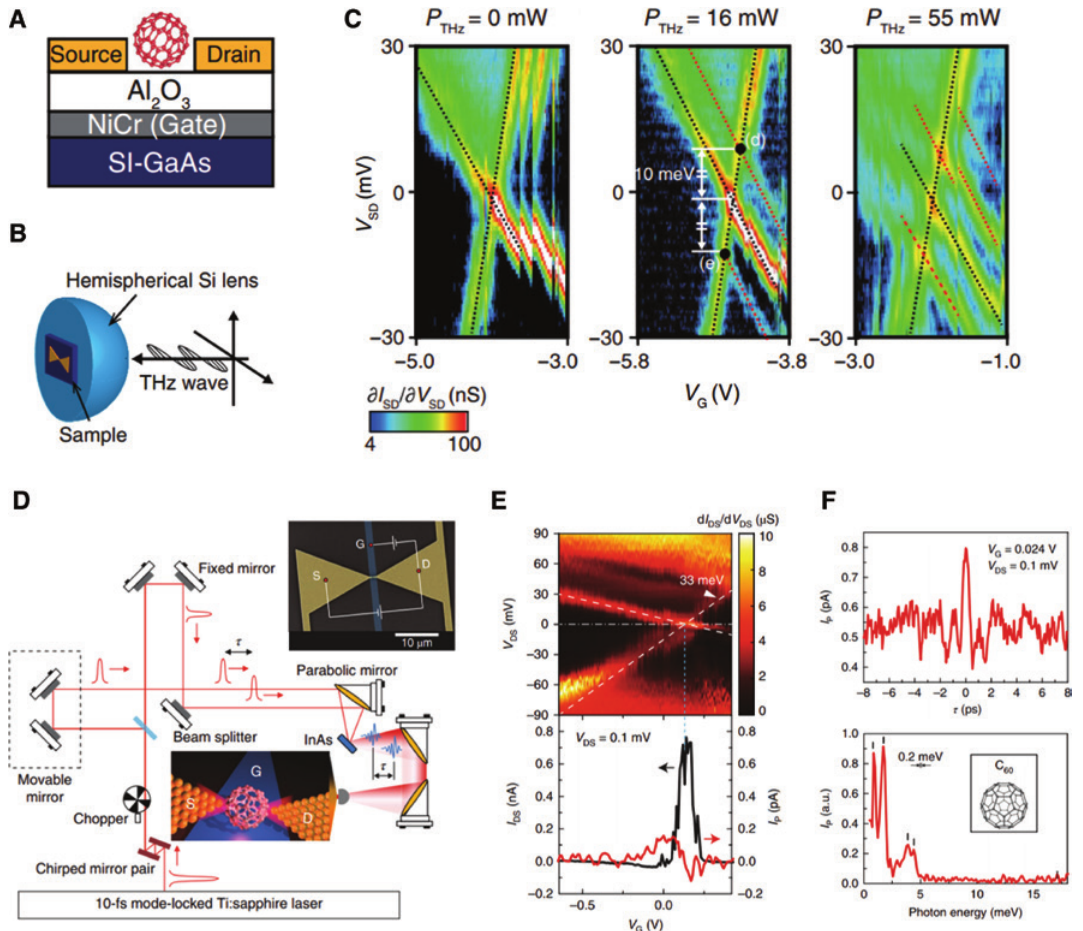
Figure 7: Photon-assisted tunneling in single-molecule transistors based on a bowtie antenna. (A, B) Schematic of cross-sectional view for a single-molecule transistor where a fullerene molecule is trapped in a bowtie antenna and the sample mounted on a hemispherical silicon lens, respectively. (C) Coulomb stability diagrams under the terahertz irradiation with three different powers [0 mW (left), 16 mW (middle), and 55 mW (right)] and a fixed frequency (2.5 THz). (D) Setup for single molecule terahertz spectroscopy based on terahertz autocorrelation system. (E) Coulomb stability diagrams (top), the single electron tunneling current (black), and the terahertz-induced photocurrent (red) as a function of gate voltage at a source-drain voltage of 0.1 mV (bottom) for C molecule transistor. (F) Quasi-autocorrelation trace of the terahertz-induced photocurrent and its Fourier spectrum. The figures (A–C) and (D–F) are reproduced from References [50] and [82],